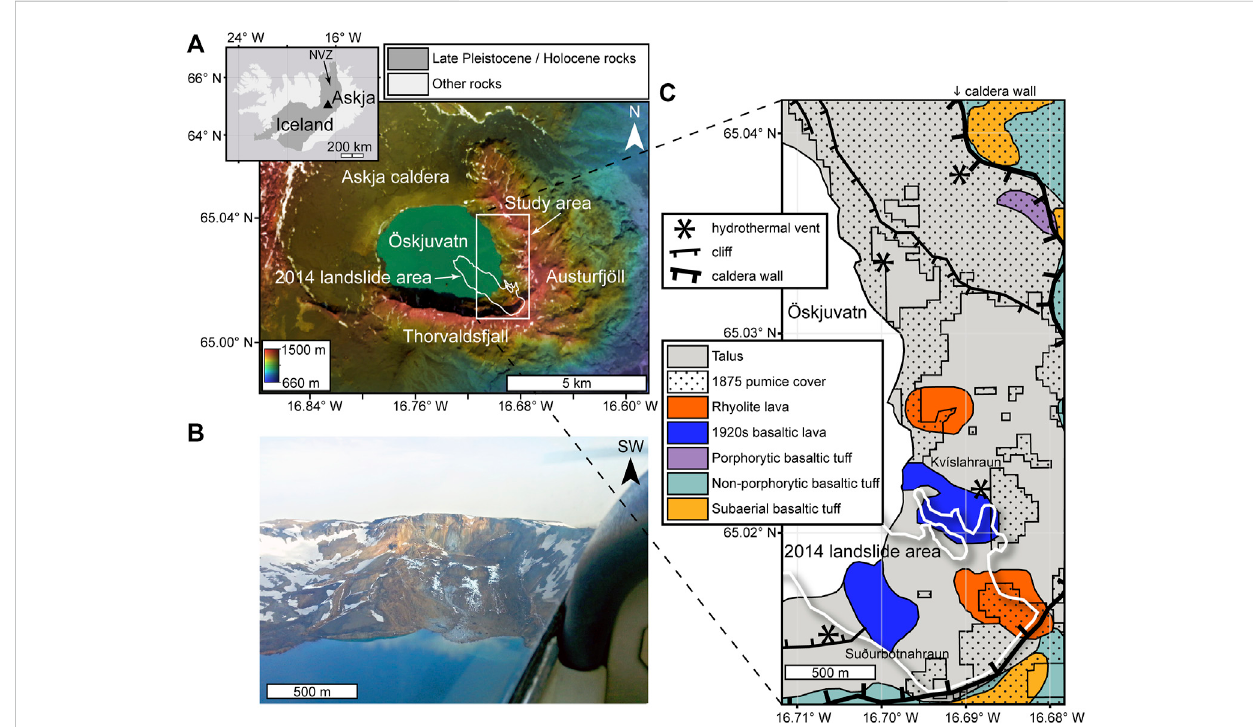
FIGURE 1 Areaofthe21July2014landslide. (A) Landsat8satelliteimage(bands4-3-2,sceneof6September2014)andEU-DEMv.1.0elevationmap(showing the topography) of the Askja Caldera in the Northern Volcanic Zone (NVZ) of Iceland (see inset map). The location of the study area on the east of Lake Öskjuvatn and the areal extent of the 2014 landslide are outlined in white (landslide outline adapted from Gylfadóttir et al., 2016). (B) Aerial photograph taken one day after the landslide, showing the landslide headwall, and the light-colored red-brownish altered rocks partly covering black basaltic lava- fl ows (image provided by Magnus T. Gudmundsson). (C) Pre-slide geological map of the study area detailing the onshore portion of the landslide (lithological units adapted from maps of Graettinger, 2012; Graettinger et al., 2013, shoreline and caldera wall morphology adapted from post-slide VHR satellite imagery). The approximate extent of the 2014 landslide is shown by the white